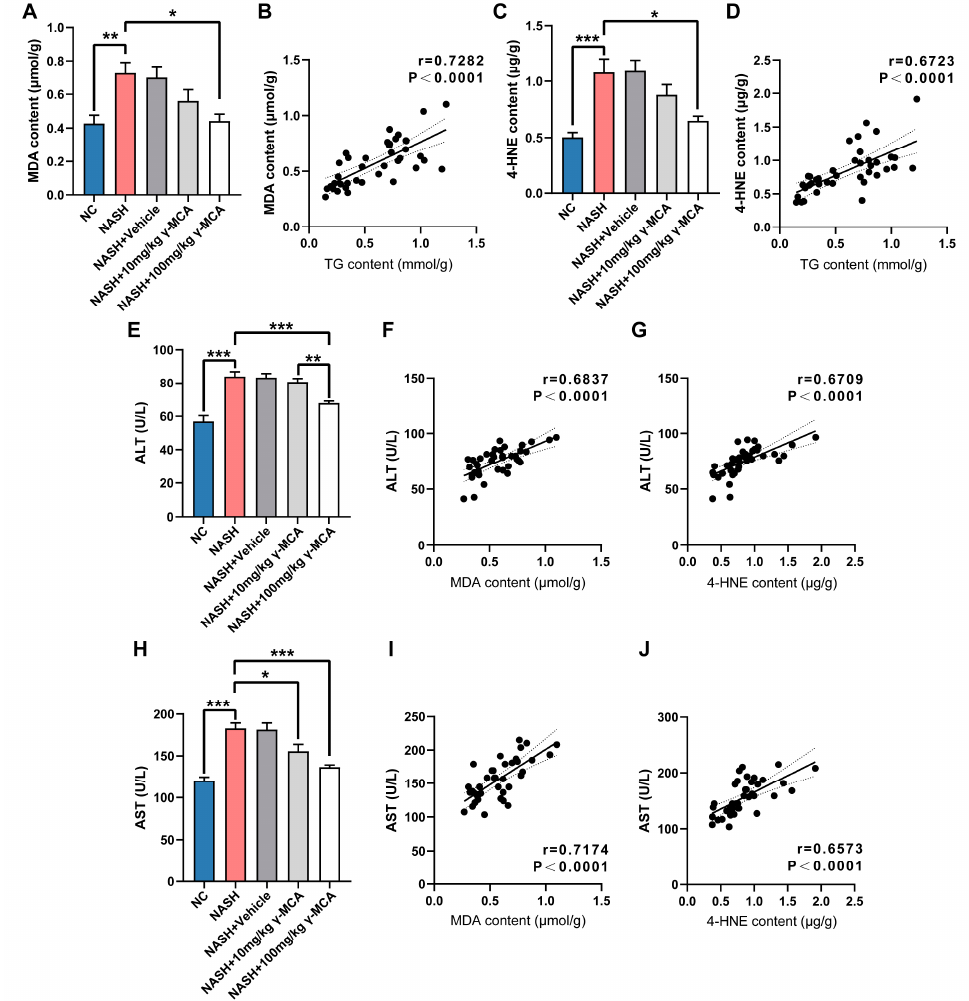
Figure 4. γ -MCA-based steatotic attenuation mitigated lipid peroxidation and oxidative impairment. ( A – D ) Both MDA ( A ) and 4-HNE ( C ) were upregulated in the NAFLD group and significantly reduced in the 100 mg/kg γ -MCA group, with strong correlations with hepatic TG content ( B , D ). ( E – J ) The NAFLD group exhibited an increase in the serum levels of ALT ( E ) and AST ( H ), both of which experienced a significant decrease in the 10 mg/kg γ -MCA and/or NAFLD + 100 mg/kg γ -MCA groups. In addition, both ALT and AST were positively associated with MDA ( F , I ) and 4-HNE ( G , J ). The data were presented as the mean ± SEM. *, p < 0.05; **, p < 0.01; and ***, p <